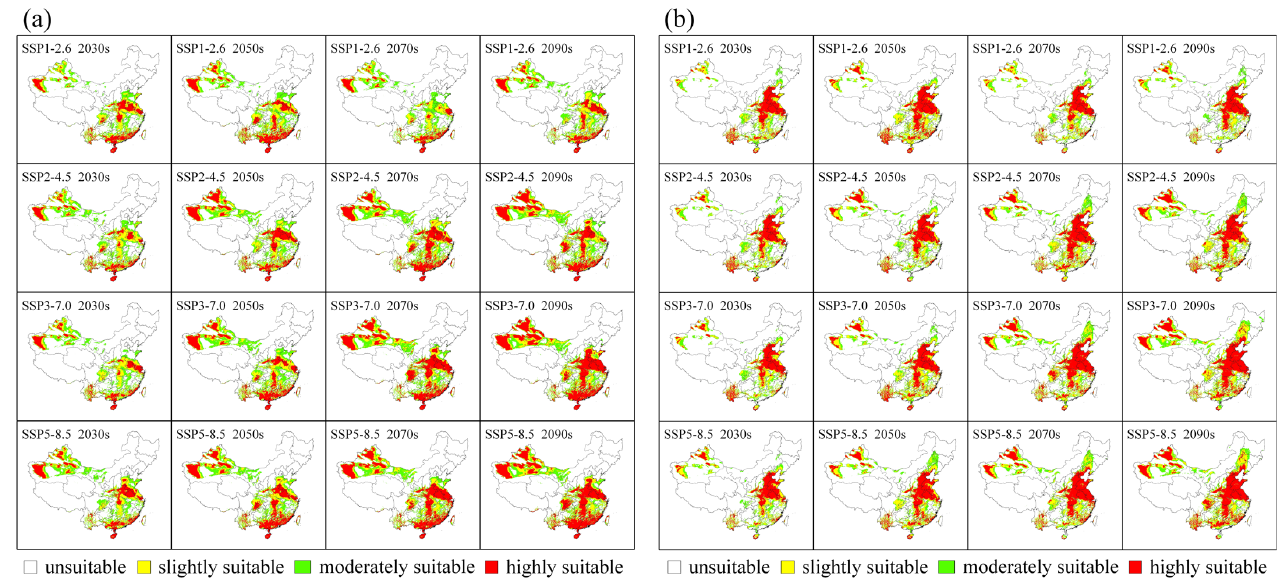
Figure 3. Suitable habitat distribution of ( a ) MEAM1 and ( b ) MED cryptic species of the Bemisia tabaci species complex in China under future climate scenarios. SSP, shared socioeconomic pathway.